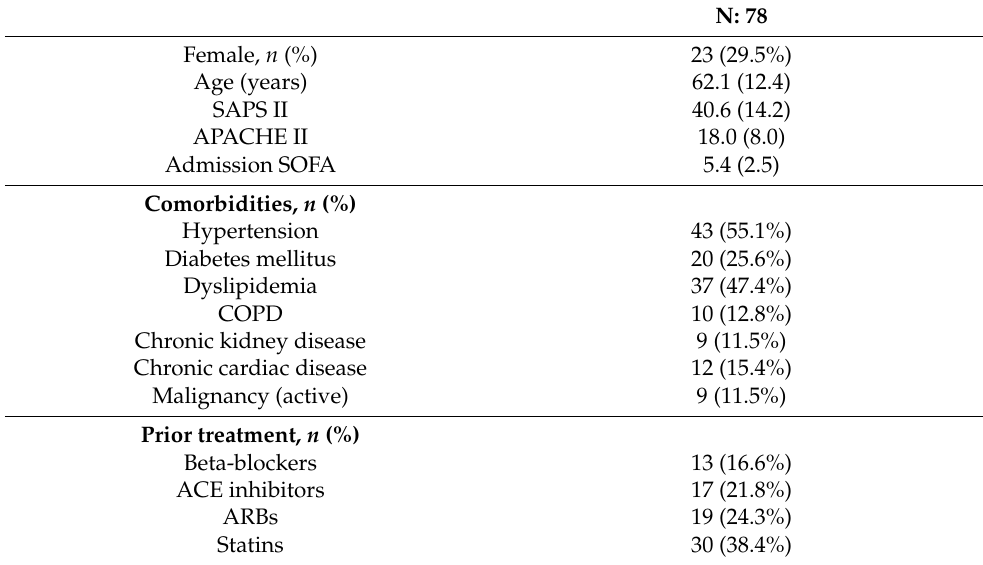
Table 1. Baseline clinical characteristics of the critically ill COVID-19 patients included in the